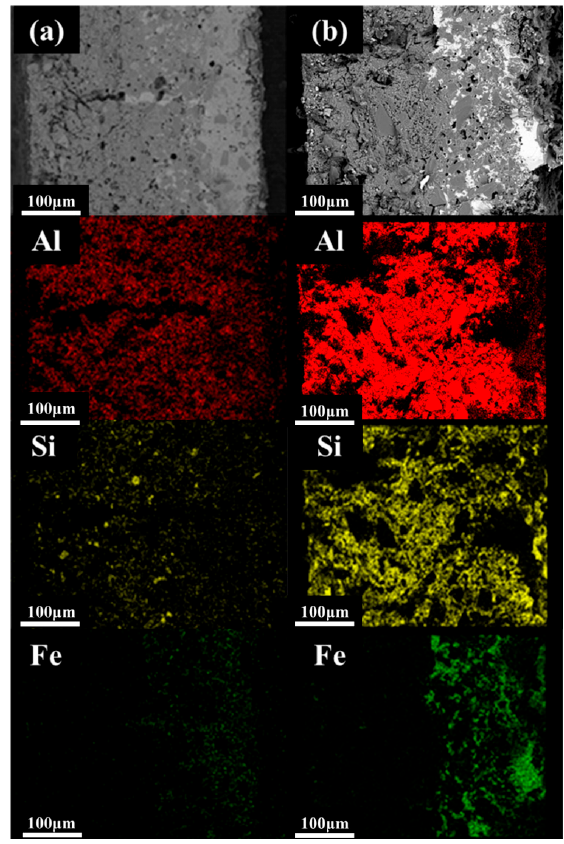
Figure 10. SEM-EDS images of cross-sections belonging to ( a ) the sample protected by ASMA and ( b ) the sample protected by AS at 1250 °C.